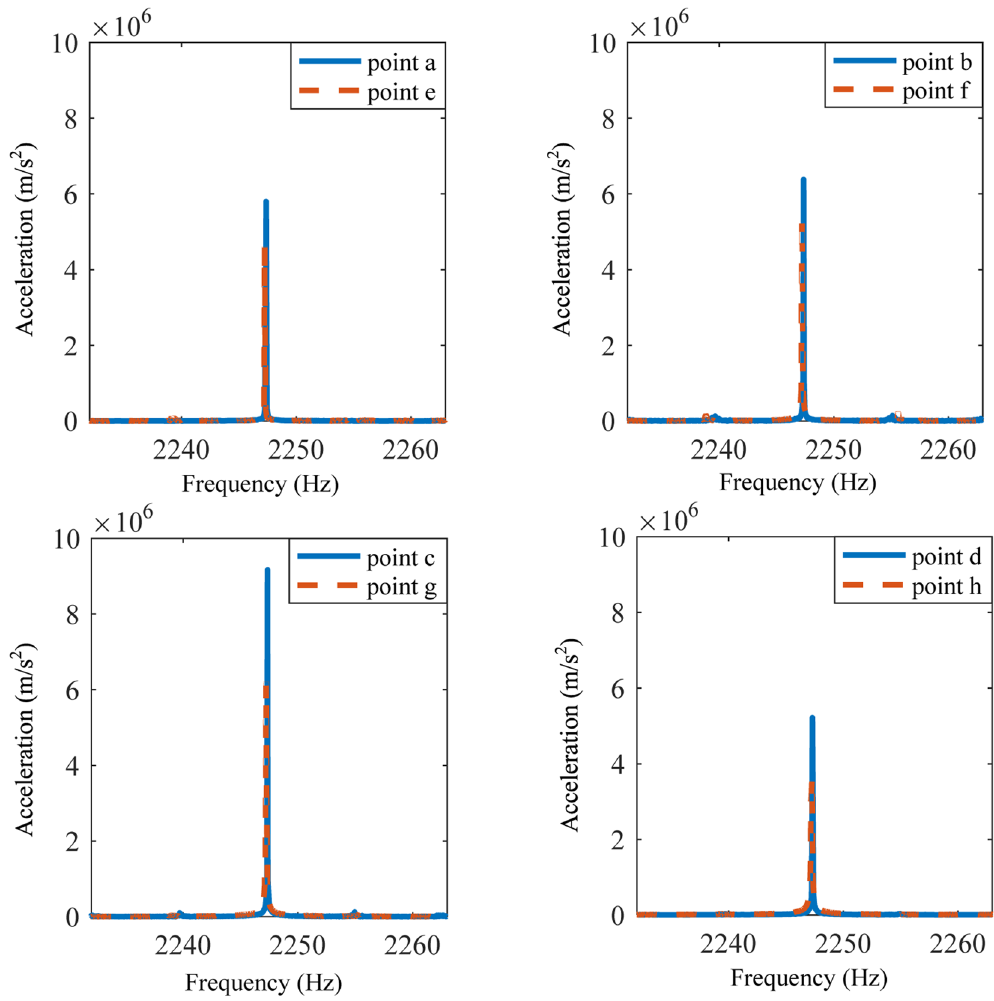
Figure 5. Responses of points a-h at 2247 Hz when the elastic wave metamaterial plate is attached by the active control